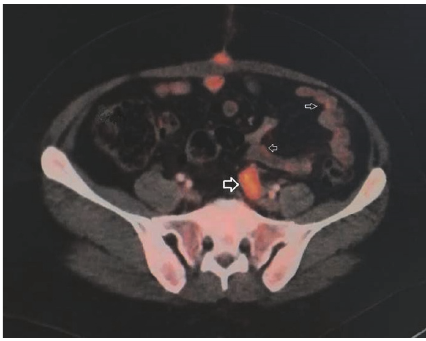
Figure 4: Abdominal positron emission tomographic (PET-CT) scan. Axial view shows variable-sized heterogeneous contrast- enhancing above rectosigmoid mesentery towards the left abdom- inal wall in pelvic floor (arrowheads). Arrow shows the lateral port site